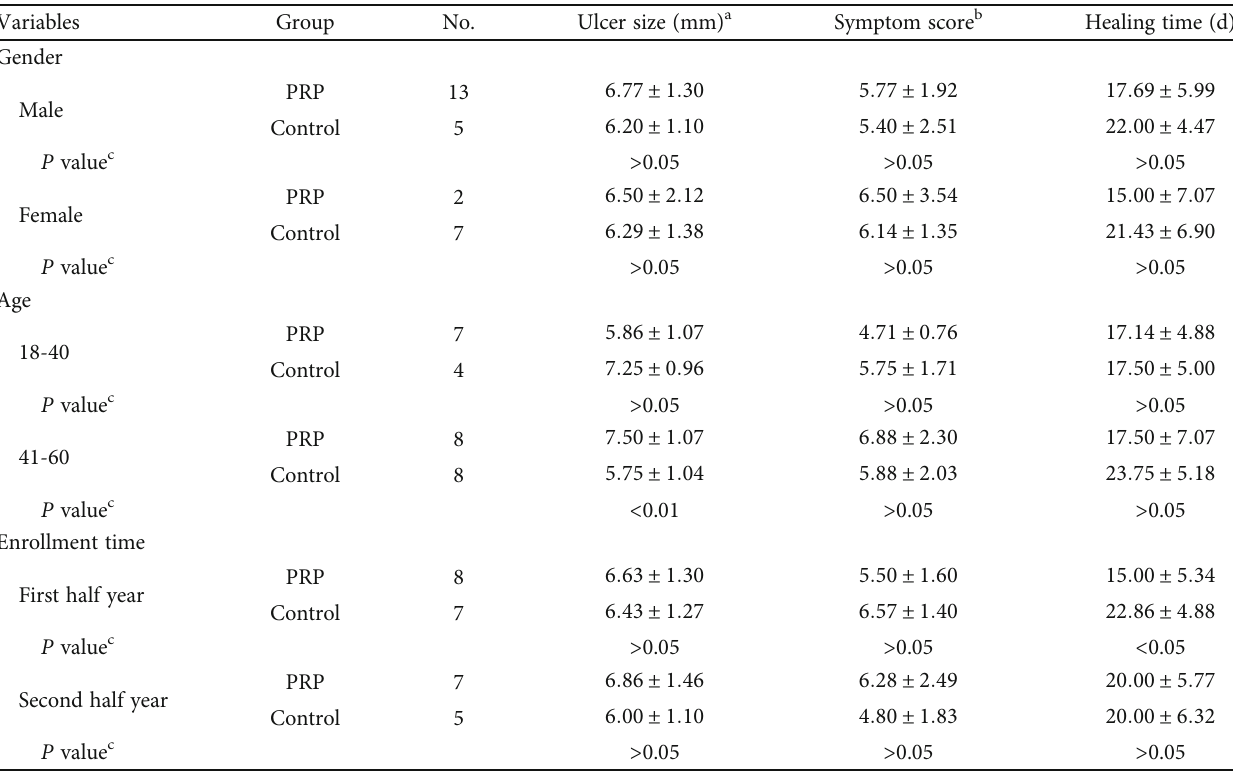
Table 4: Comparison of healing time in di ff erent variables in peptic ulcer healing.